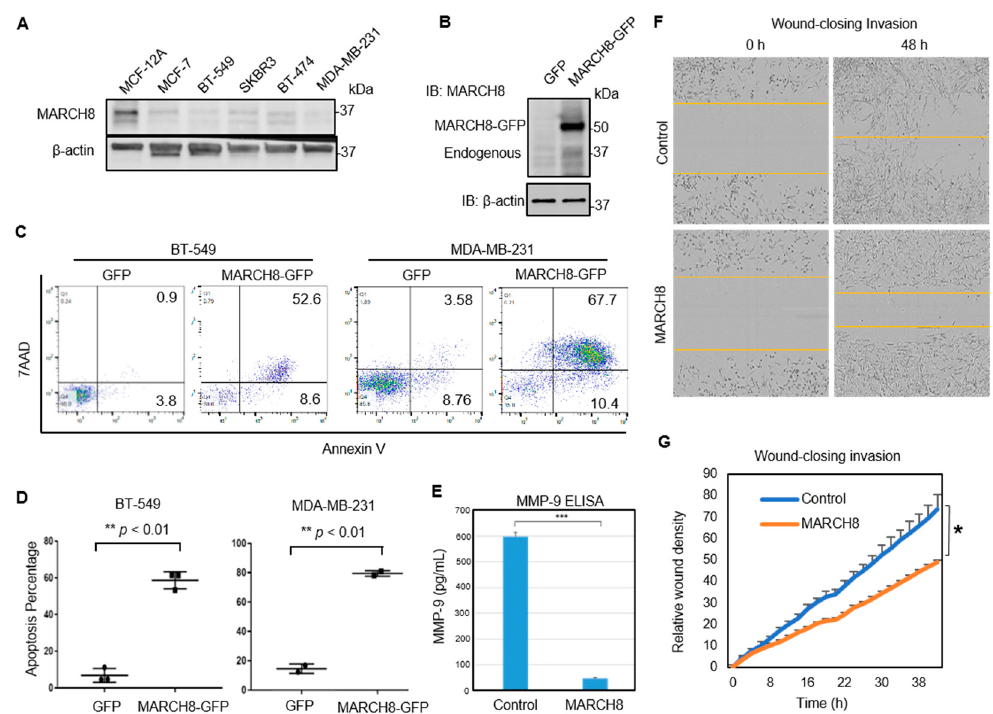
Figure 3. MARCH8 overexpression induces cell apoptosis, reduces MMP-9 levels, and compromises cell invasion. ( A ) Immunoblots of endogenous MARCH8 protein expression (~37 kDa) in immortalized normal mammary epithelial cell line MCF-12A and breast cancer cell lines including MCF-7, BT-549, SKBR3, BT-474, and MDA-MB-231. ( B ) Immunoblots of MARCH8 indicating the overexpression of fused MARCH8-GFP (~50 kDa) in MDA-MB-231 cells after transient transfection in comparison to a GFP vector control. ( C , D ) Transient transfection of MARCH8 significantly promotes cell death in BT-549 and MDA-MB-231 breast cancer cells, as indicated by annexin V levels (apoptosis) and 7AAD (DNA dye). ** t -test p < 0.01. ( E ) ELISA-detected MMP-9 levels in the supernatant of the control and MARCH8-overexpressing cells. *** t -test p < 0.001. ( F , G ) Images ( F ) and cell invasion-based wound closure curves ( G ) of MDA-MB-231 control and MARCH8-overexpressing cells between 0 and 48 h after wound scratch, analyzed by Incucyte time-lapse imaging. * p < 0.05.